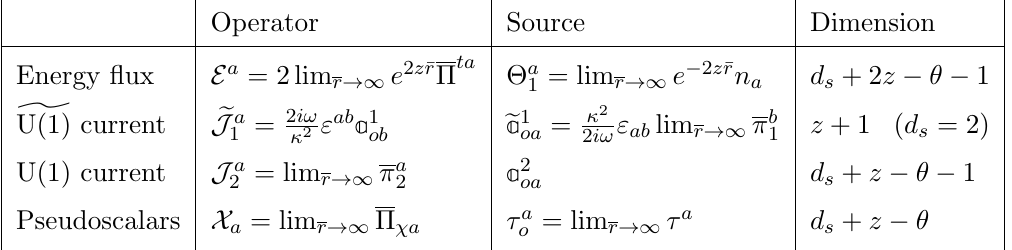
Table 2 . Spectrum of operators corresponding to Neumann boundary conditions on A 1